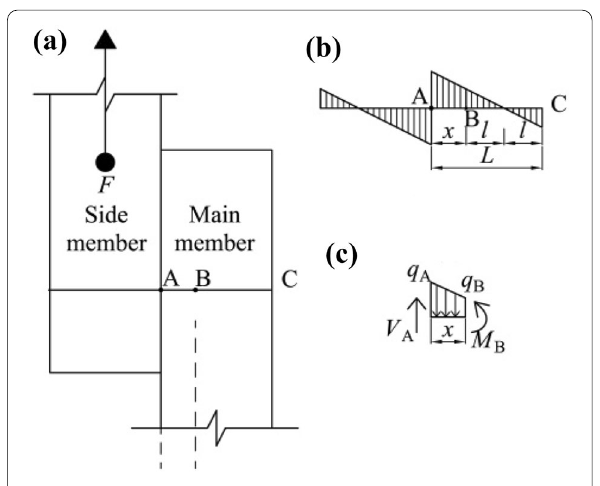
Fig. 12 The linear mechanical model ( a ) of single staple legs in single-shear plywood-to-plywood single-staple connections subjected to a static lateral load with its complete ( b ) and section free-body diagrams ( c